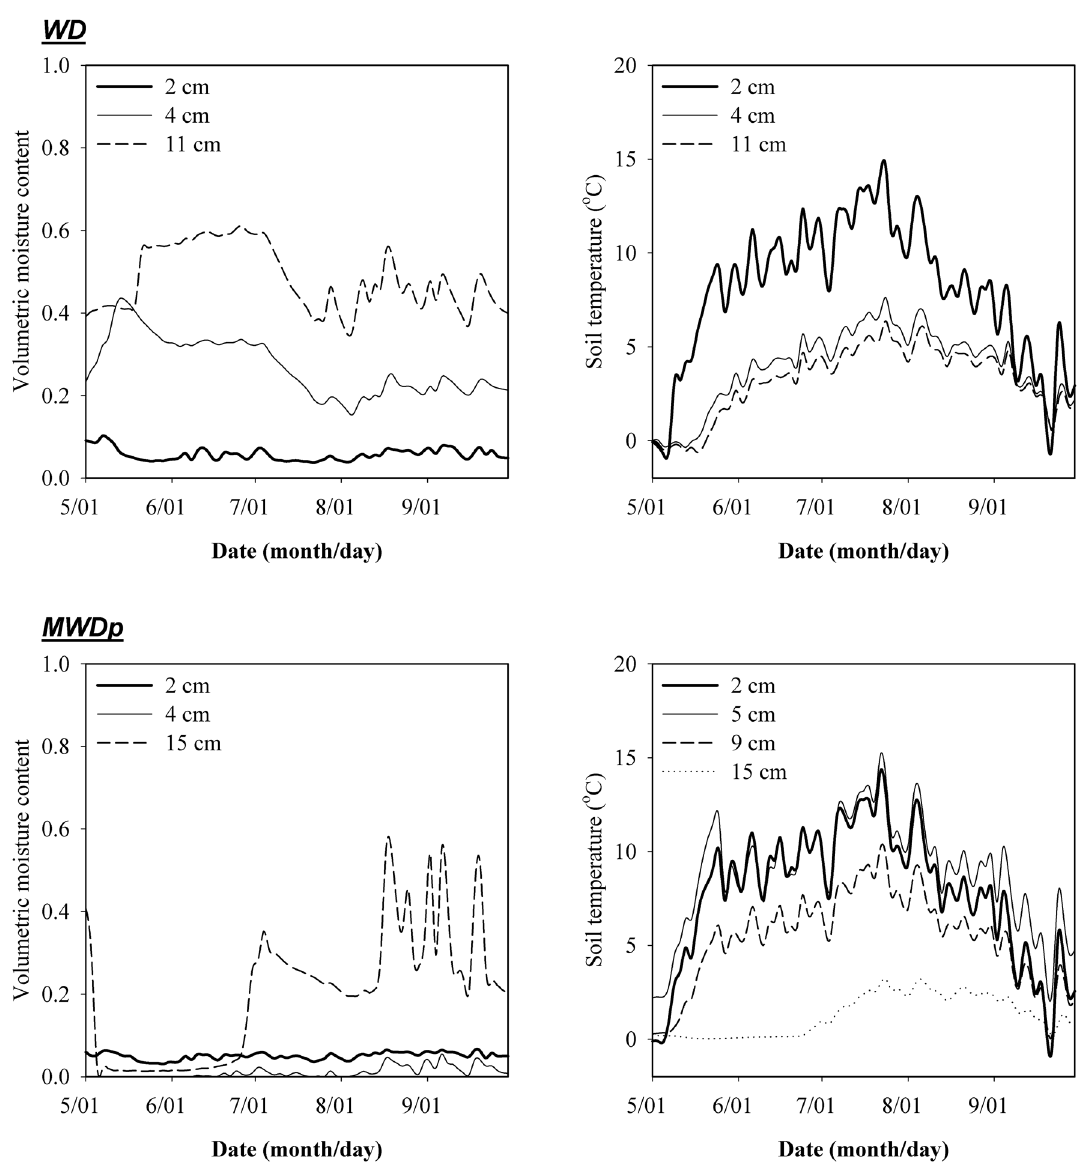
Figure 1. Soil moisture and temperature at measured soil depths in the well-drained site without permafrost (WD) and in the moderately well-drained site with permafrost (MWDp).